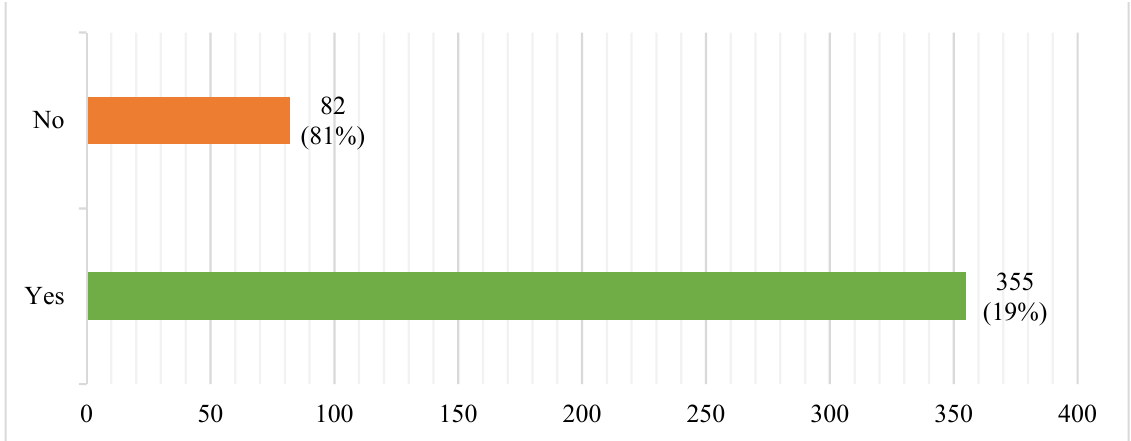
Figure 3. Frequency for the response for ‘is there existing mismatch between the current and require skills sets needed for graduate employability.’.